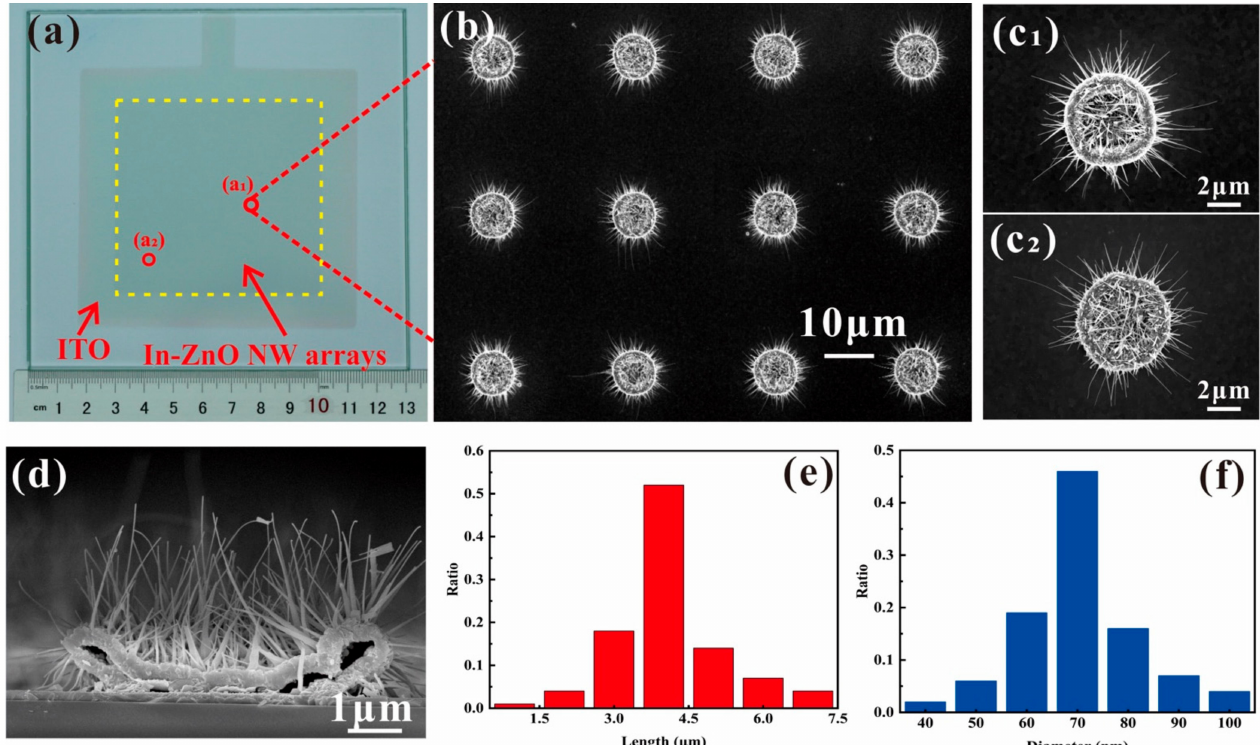
Figure 1. Images of ZnO nanowire arrays with indium doping. ( a ) Photograph consist of glass substrate, indium–tin-oxide (ITO) electrode and the prepared ZnO nanowire field emission arrays (FEAs) with indium doping; ( b ) top view SEM image of a 4 × 3 In-doped ZnO nanowire pattern array in low magnification; ( c 1 , c 2 ) single pattern at different regions in high magnification; and ( d ) cross-sectional SEM image of a single pattern; ( e , f ) Statistical results of the length and